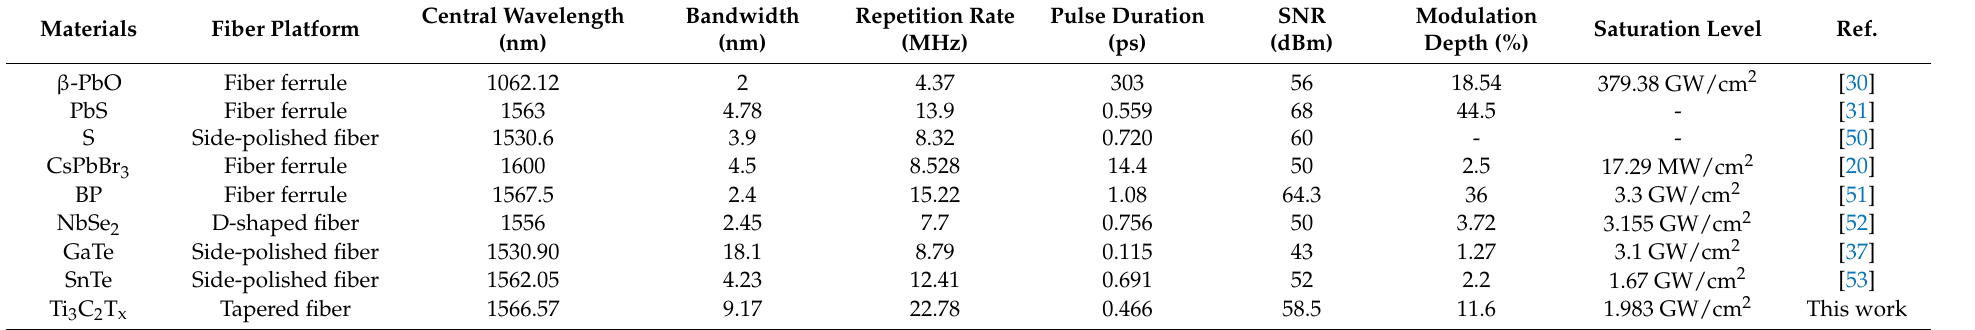
Table 1. Comparison of mode-locking performance of fiber lasers based on various QDs